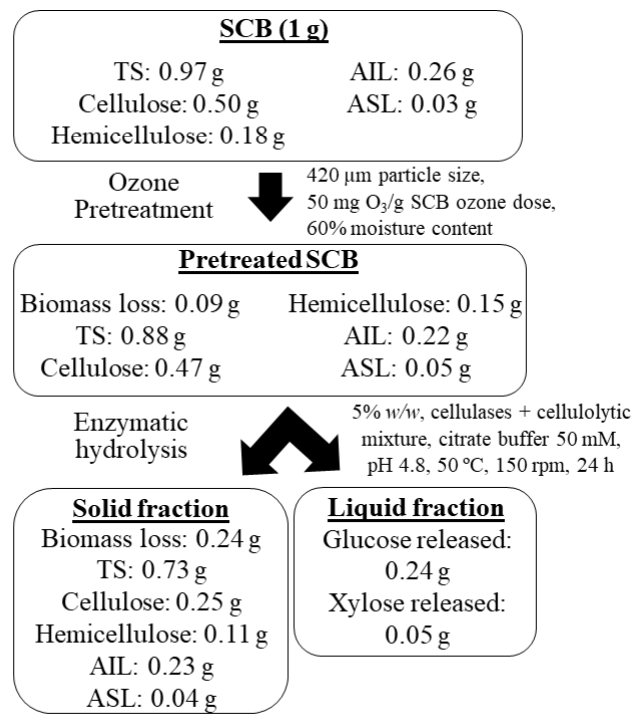
Figure 7. Mass balance for the ozonation of sugarcane bagasse (SCB) at an applied ozone input of 50 mg O 3 /g SCB, a particle size of 420 µm, 60% moisture and 30 min exposure time.